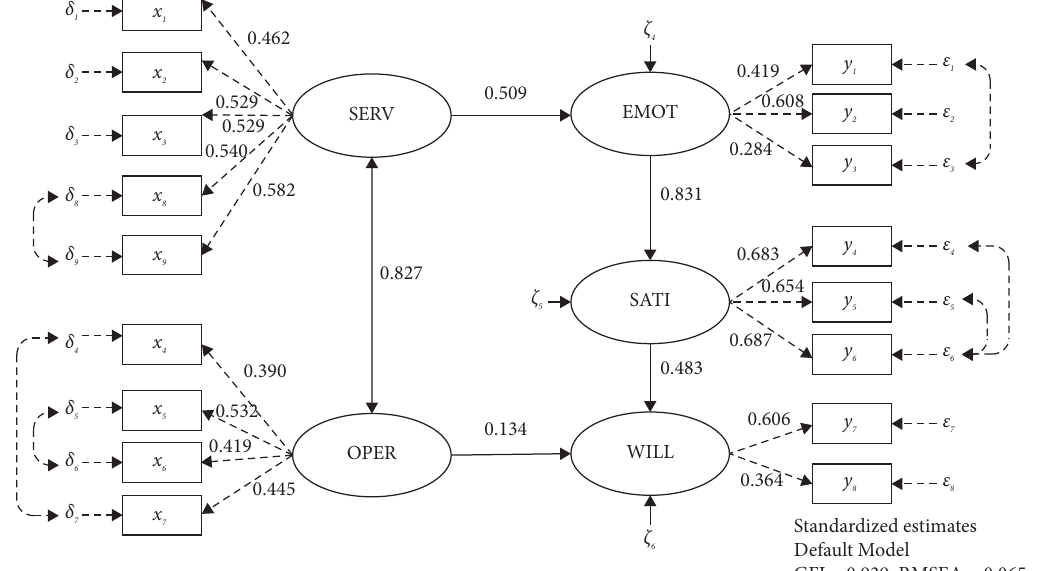
Figure 4: Results of the adjusted